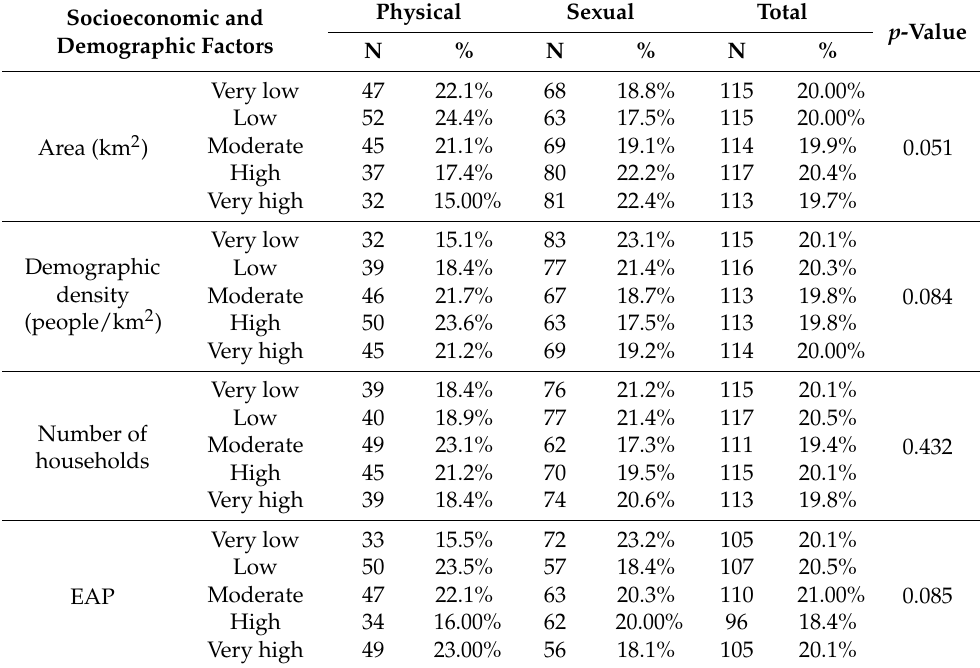
Table 4. Association between the incidence of physical and sexual violence and socioeconomic and demographic factors extracted by census